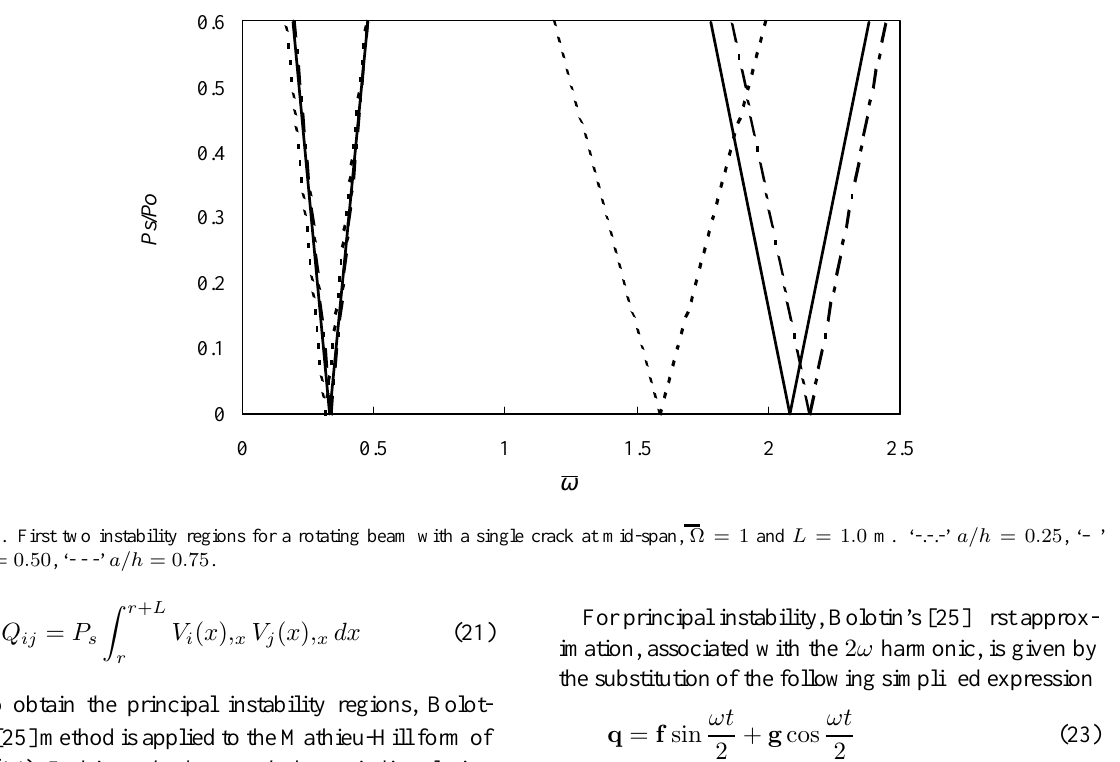
Fig. 3. First two instability regions for a rotating beam with a single crack at mid-span, L = 1 . 0 m and a/h = 0 . 5 . ‘-.-.-’ Ω = 0 . 5 , ‘–’ Ω = 1 , ‘- - -’ Ω = 2 .